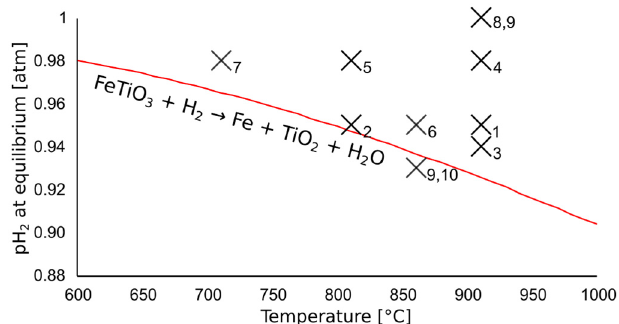
Figure 3. Calculated equilibrium partial pressure for the metallization reaction in red. The black crosses and the experiment number show the conditions of temperature and gas composition for the experimental work. Experiment 9 appears twice as the gas mixture was shifted during the